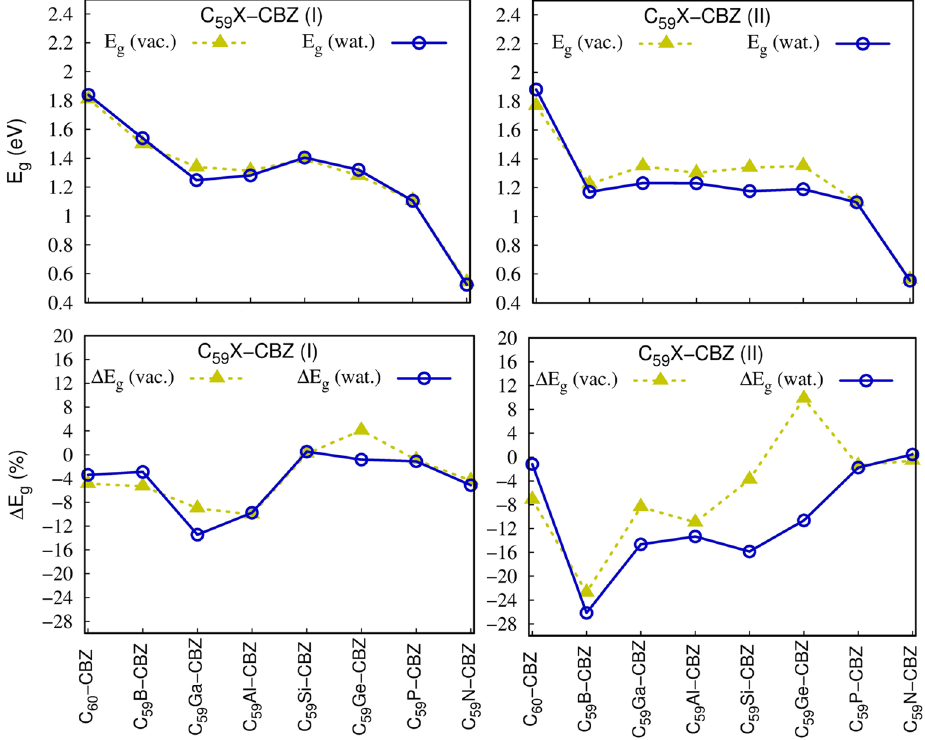
Figure 3. (Top panel) HOMO–LUMO gap energy (E g ) of C 59 X in the complex configuration (C 59 X + CBZ) in vacuum and water (PCM) and (lowest panel) percentual change of E g (ΔE g ) with respect to its value prior to the CBZ adsorption. These calculations were performed at the M06L/6-31G(d)//wB97XD/6-31G(d) level of